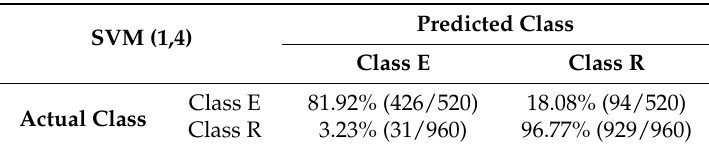
Table 7. Confusion matrices for cross-validation.